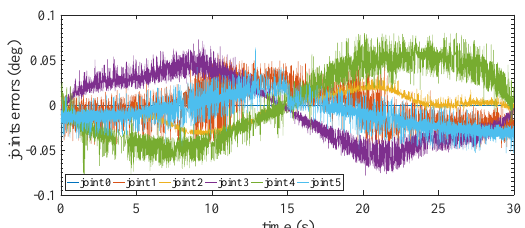
ranges from − 0 . 022 to 0 . 026 mm. In Fig. 14: Position error ranges from − 0 . 021 to 0 . 020 mm.